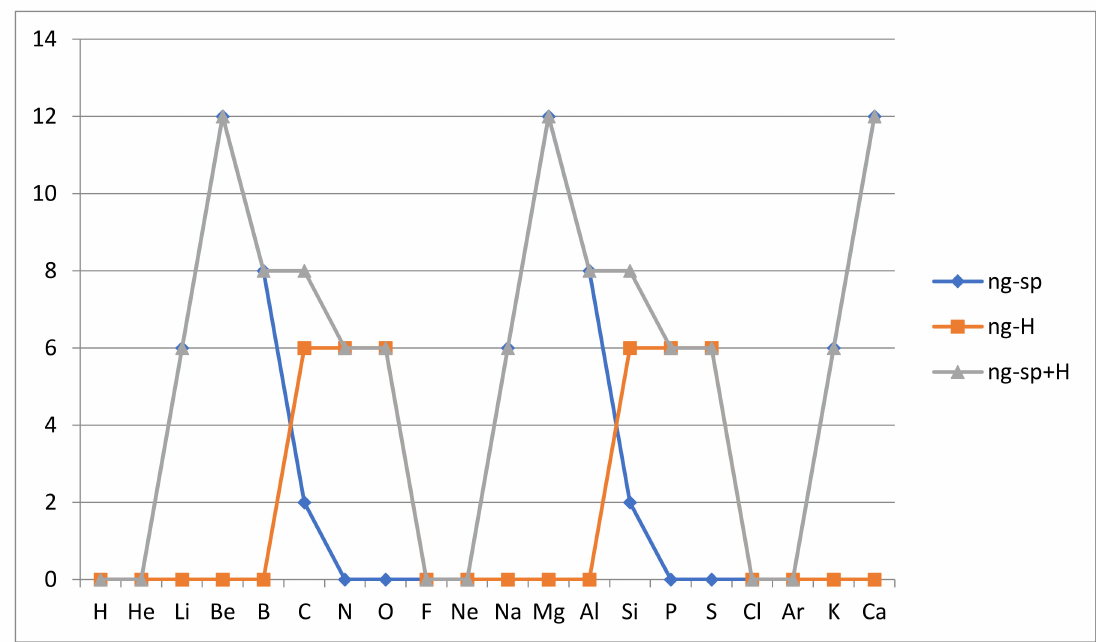
Figure 6. The variation in s-p and spin flip (Hund’s rule) near-degeneracy of the Aufbau ground state is shown for the atoms H through Ca. The sum of these near-degeneracies ng-sp + H = ng-sp + ng-H is also